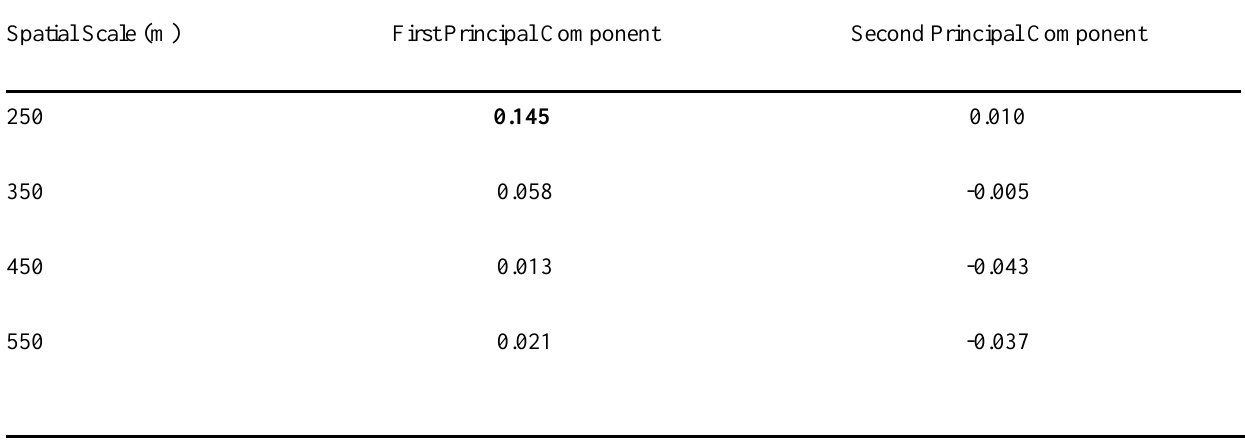
Table 2. Spatial autocorrelation of the first two components of a principal component analysis as indicated by Moran’s I correlograms. Negative Moran’s I values indicate regular arrays, whereas positive values indicate clusters. Numbers in bold are significant at P